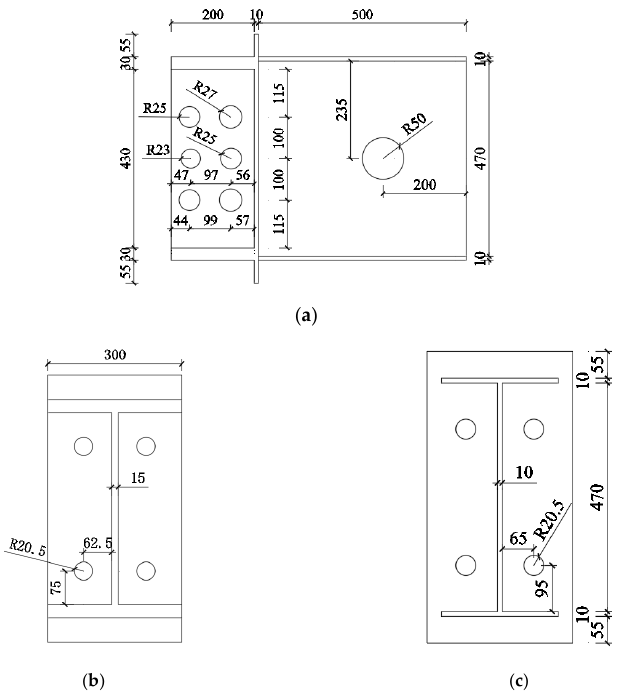
Figure 5. Dimensions of the steel head (unit: mm): ( a ) Front view of the steel head; ( b ) Left view of the steel head; ( c ) Right view of the steel head.